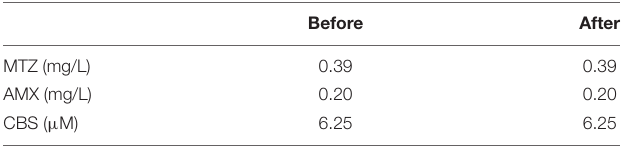
TABLE 2 | MICs of MTZ, AMX, and CBS against P. gingivalis persisters following 3-time treatments and recoveries # . Before After